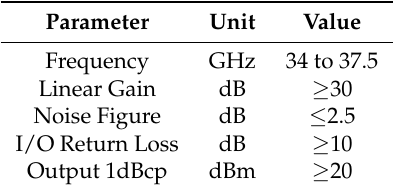
Table 2. Designed low-noise amplifier (LNA)